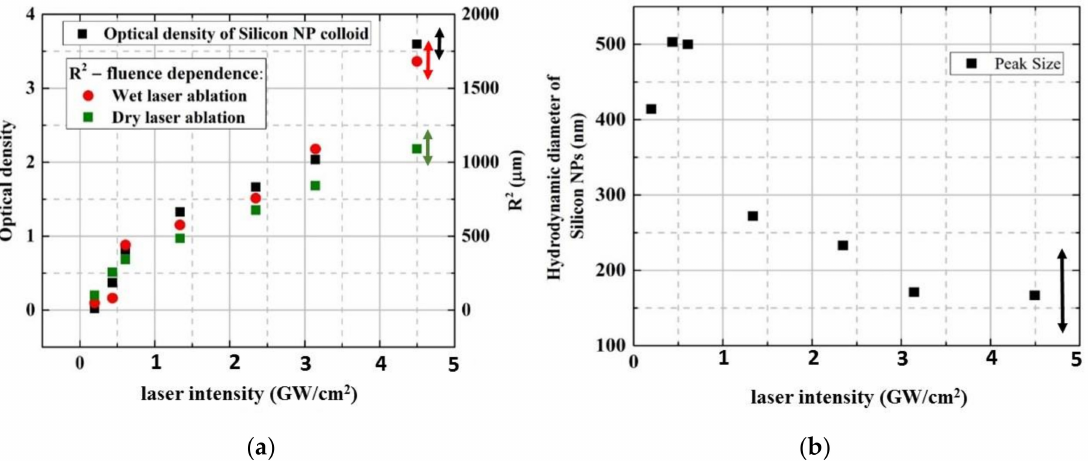
Figure 7. ( a ) Optical density of Si colloid vs. laser intensity in correlation to ablation spot square (for comparison, both dry and wet ablation spot squares are given). ( b ) Hydrodynamic diameter of Si NPs versus laser intensity. The experimental error ranges are shown by the bilateral colored